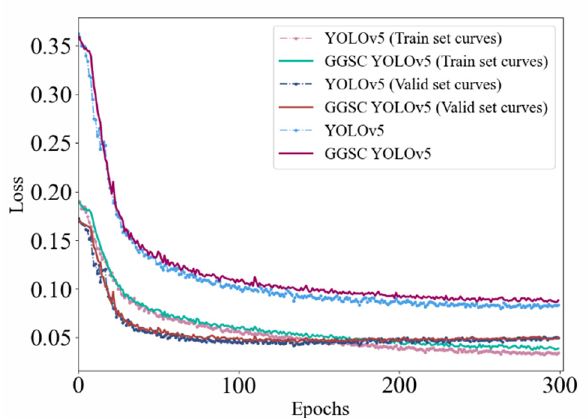
Figure 8. Loss value convergence curve with epoch times.